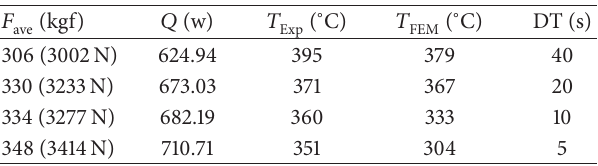
Table 2: Experimental and numerical temperature results for 1000 rpm and different dwell